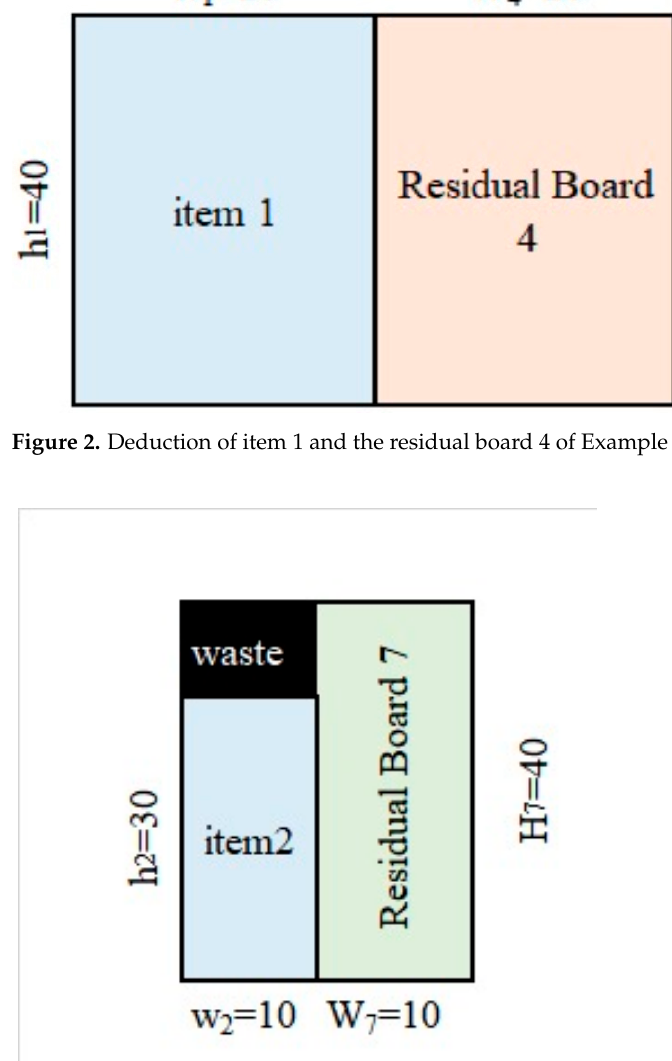
Figure 2. Deduction of item 1 and the residual board 4 of Example 1.